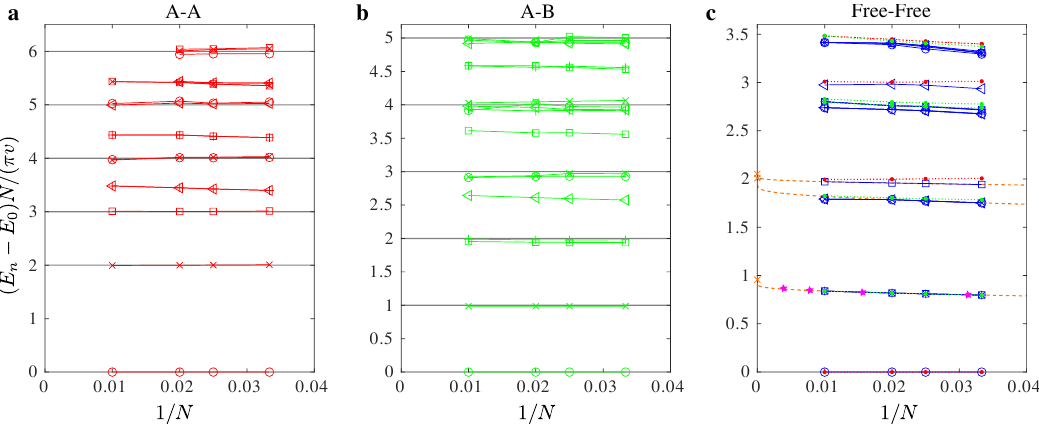
Figure 3: Conformal towers of states of the four-state Potts model with a fixed sym- metric and b fixed antisymmetric and c free boundary conditions. Symbols are DMRG data points extracted from the low-lying energy excitation spectra with ve- locity v = π/ 4. The velocity computed from the lowest energy gap in a v ≈ 0.785 is in excellent agreement with this value. Gray lines are integer levels shown for refer- ence. In c the results from a (red) and b (green) are shown as a reference, the latter is shifted such that it starts at the first excites state of the Free-Free tower. Each level in Free-Free tower that matches a level of the A-B tower is three-fold degenerate. Magenta stars are results from the Bethe ansatz calculations [ 9 ] , the agreement with DMRG data is within 0.5%. Orange dashed lines are finite-size extrapolation assum- ing log-corrections in the form derived by Cardy [ 45 ] . Extrapolated results (orange crosses) agree within 5% with the exact result x = 1 [ 9 ] and x = 2 for higher